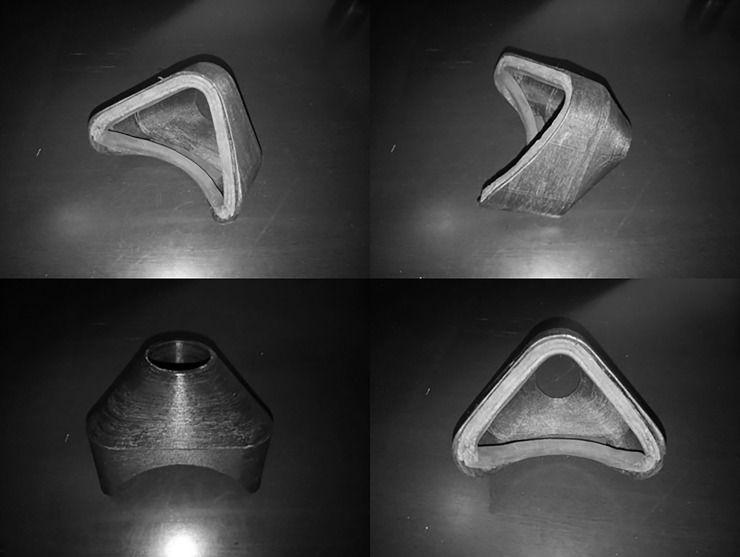
Piece to connect the ARM to the gas analyser.The 3D piece was used to connect the ARM to the gas analyser. The complex ARM + 3D piece had a dead space of 350 ml.